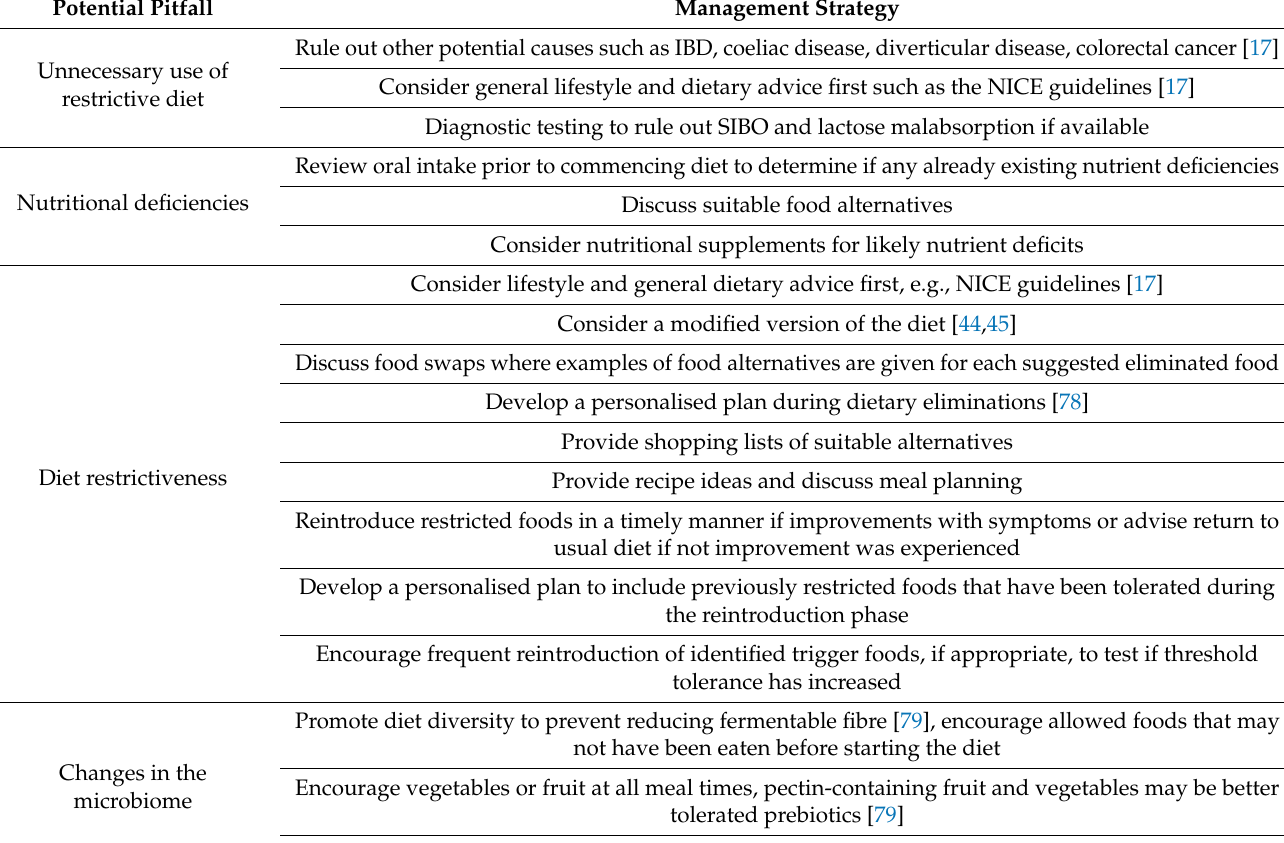
Table 4. Pitfalls of the dietary management of chronic diarrhoea and management